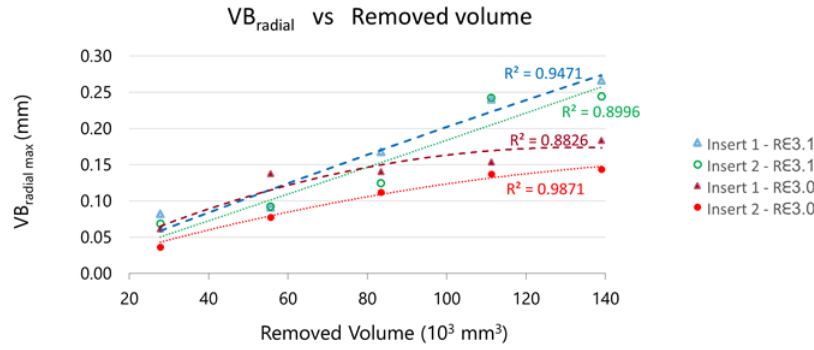
Figure 21. Evolution of maximum VB radial versus the removed volume during machining.